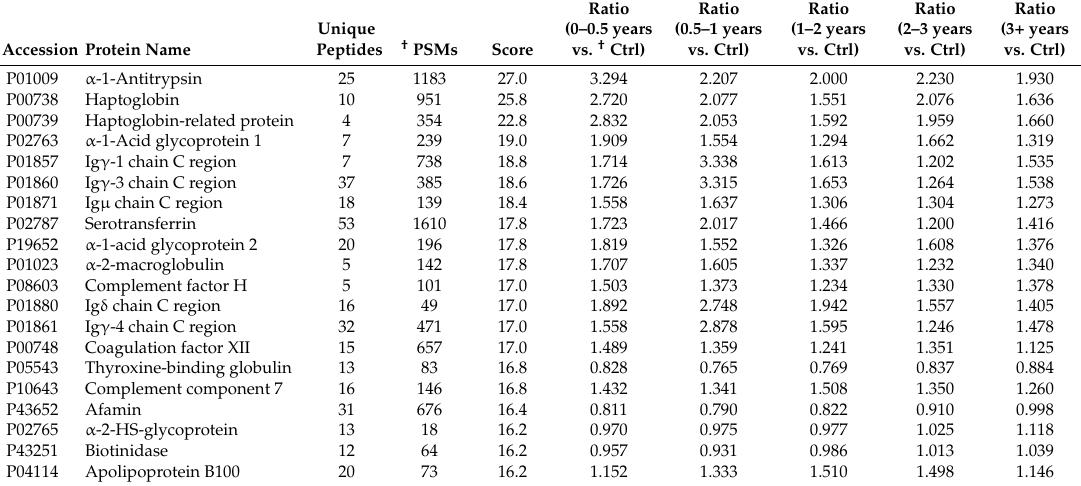
Table 1. Top scoring glycoproteins. The 20 highest-scoring glycoproteins from the analysis are shown with number of unique peptides, number of peptide spectrum matches, score, and ratios of protein expression in cases versus controls for each time